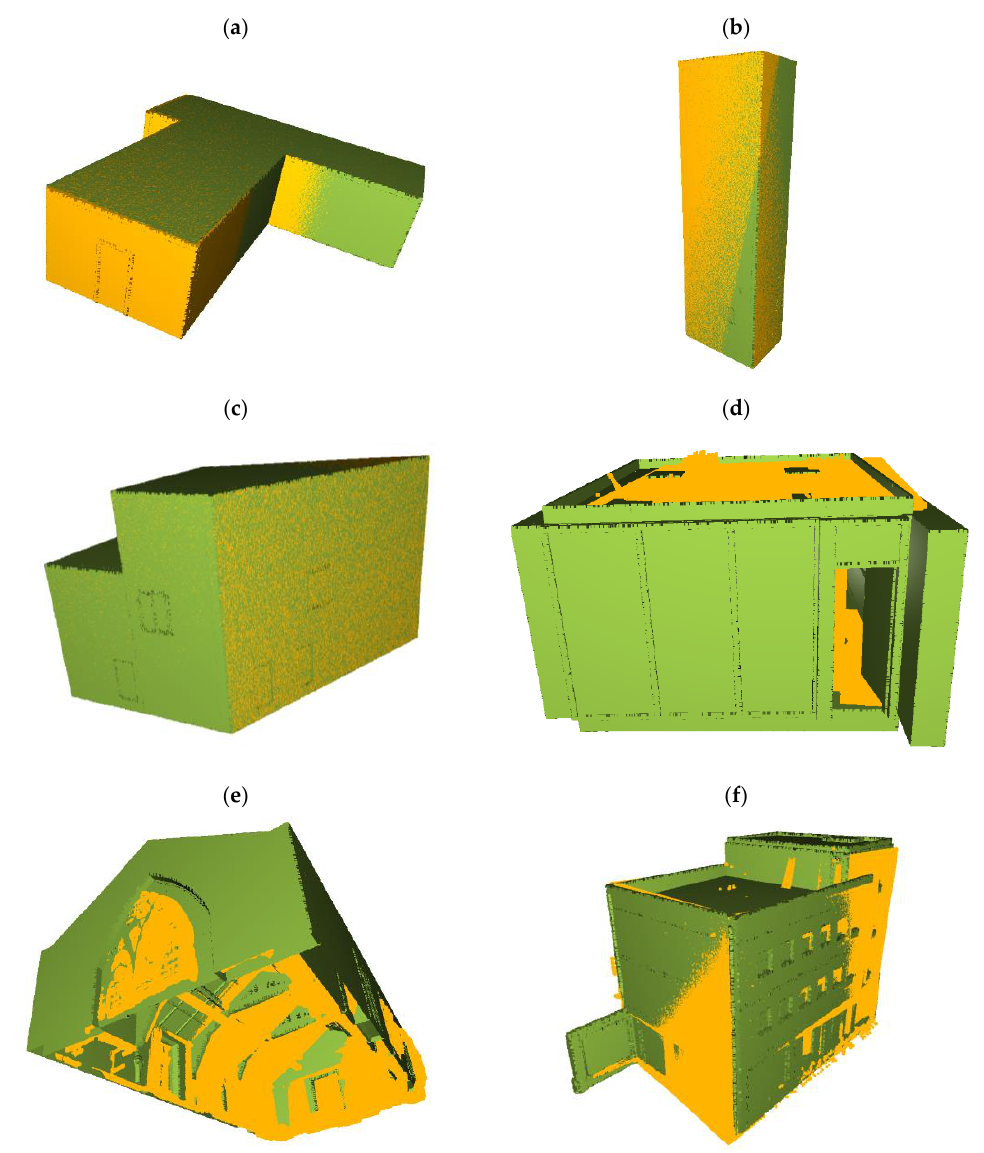
Figure 13. Visualization of the registered as-built (yellow) and as-planned (green) models of ( a ) dataset S1, ( b ) dataset S2, ( c ) dataset S3, ( d ) dataset R1, ( e ) dataset R2 and, ( f ) dataset Table 2. Registration details of all the datasets, including the computation of the correct rotation matrix and identical translation .